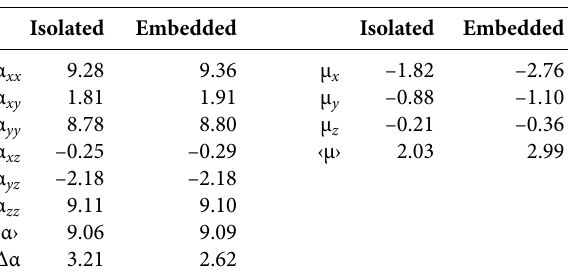
Figure 6: The Fingerprint plot forC 5 H 8 O 2 a) 100% of contacts; b) C···C; c) C···H; d) C···O; e) H···H; and f) H···O, produced from d e and d i function mapped in color showing the percentage contribu- tion of each type of interaction in total interactions verified; d e is the distance from the surface to the nearest atom exterior to the surface and d i is the distance from the surface to the nearest atom interior to the Table 1: MP2/6-311++G(d,p) results for the components and the average values of the dipole moment (in D) and the linear polariza- bility (in 10 –24 esu).